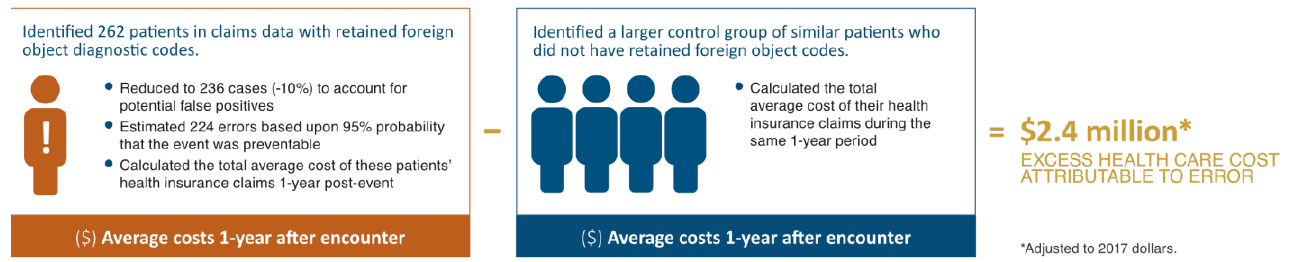
Figure 2. An estimation of the annual cost of foreign objects left in the body after surgery [57].